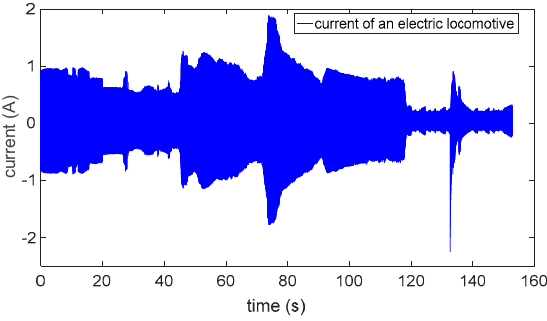
Figure 1. The current signal of an electric locomotive.